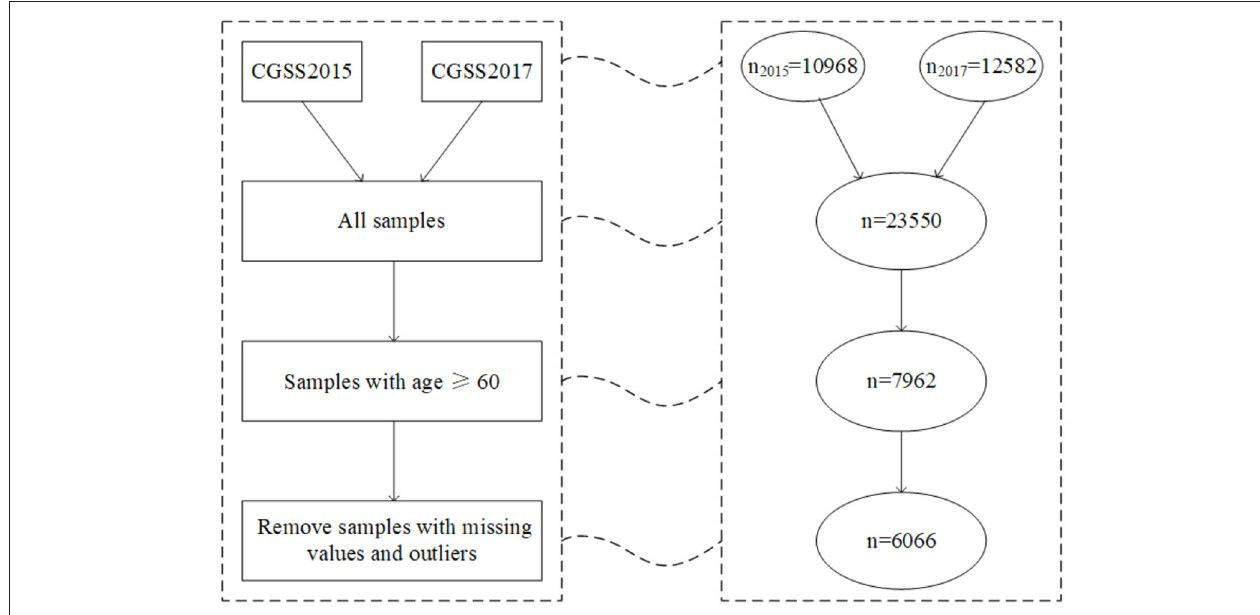
FIGURE 1 | Flowchart of sample selection and preprocessing ( n represents sample size).